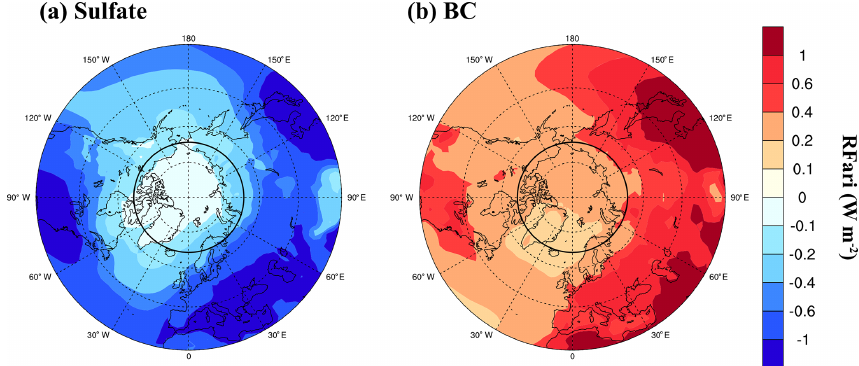
Figure 9. Spatial distribution of annual mean radiative forcing due to aerosol–radiation interactions (RF ari ) of (a) sulfate and (b) BC (Wm − 2 ) at the TOA averaged over 1980–2018. Table 3. Estimated annual mean of the response in Arctic surface temperatures (K) to the change in TOA radiative forcing due to aerosol– radiation interactions (RF ari ) of sulfate and BC, aerosol–cloud interactions (RF aci ) of sulfate, and radiative forcing (RF) due to BC in snow and ice (Wm − 2 ) in each latitude band. Forcing location Arctic equilibrium surface temperature response (K)* Sulfate RF ari Sulfate RF aci BC RF ari BC snow and ice 60–90 ◦ N 0.035